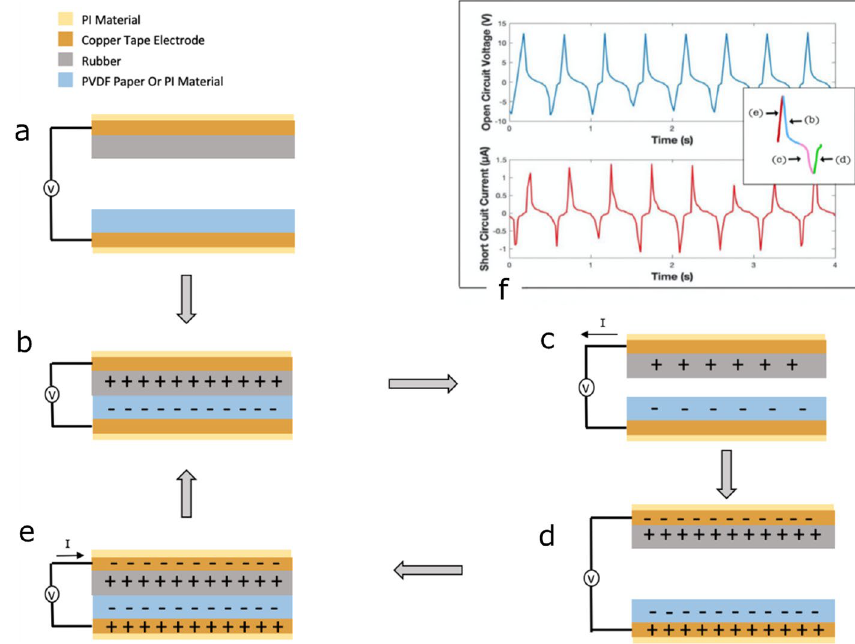
Fig. 1 a Schematic of the R-TENG. b – e Schematic rep- resentation of the operation mechanism of the R-TENG in VCSM. f Example of the typical electrical output characteris- tics of the R-TENG in terms of both open circuit voltage and short circuit current, along with a magnified inset of a single VCSM